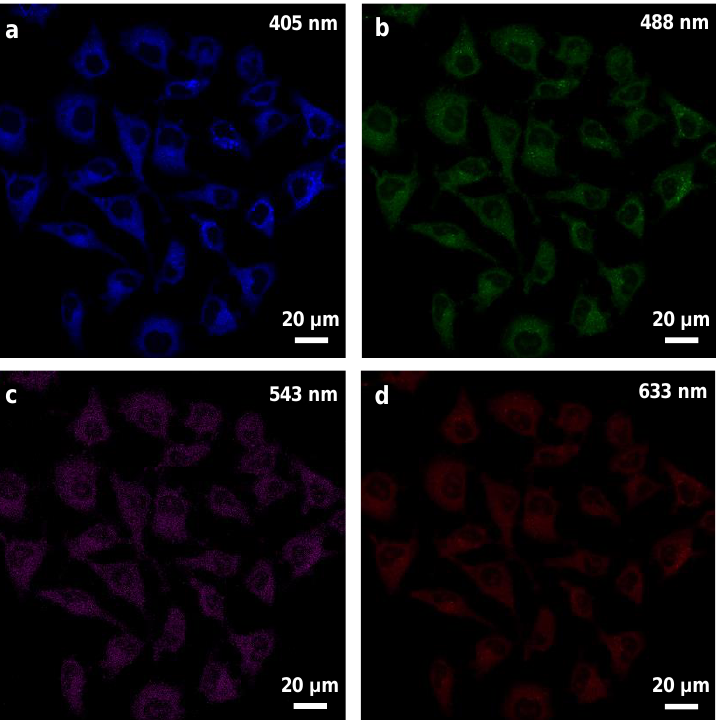
Figure 4. Cell-imaging of Cl-GQDs using HeLa cells excited at ( a ) 405 nm, ( b ) 488 nm, ( c ) 543 nm, and ( d ) 633 nm.